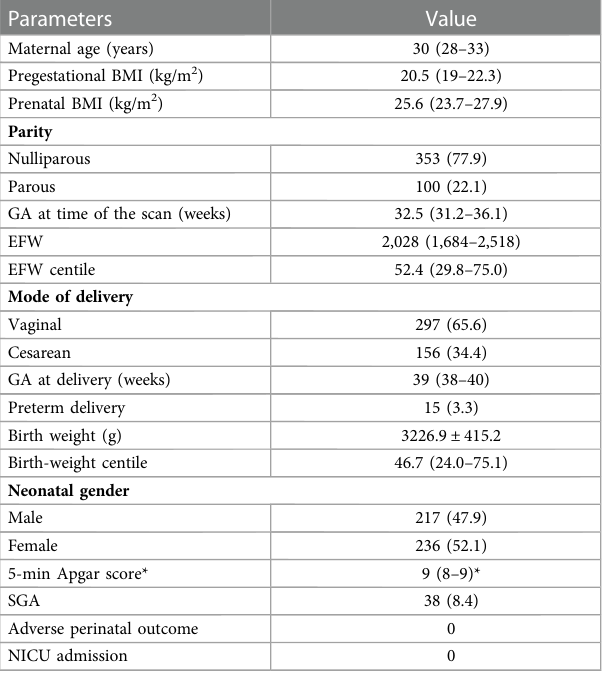
TABLE 1 Maternal and pregnancy characteristics of the study population of 453 low-risk singleton pregnancies. Parameters Value